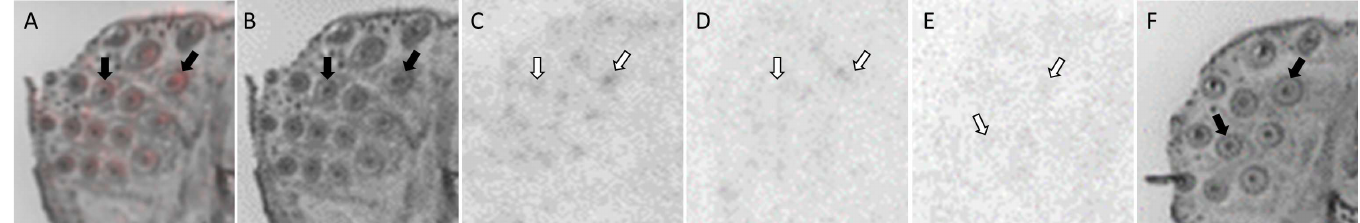
Fig 3. OXTR ligand binding in the whisker pads of a P0 male mouse. Pseudo-color composite (OXTR in red, cresyl violet counterstain in gray) (A), followedby cresyl violet counterstain (B), with black arrows indicating regionof interest. Ligandbindingspecificity was restricted to follicles. OXTR ligand bindingis indicatedby white arrows in the 0 nM OXT competition (C), followedby 1000 nM OXT competingwith OVTA radioligand to reducethe signal (D). OXTR ligandbindingwas not present in OXTR KO mice (E), followedby the post-processed cresyl violet tissue of the OXTR KO (F).